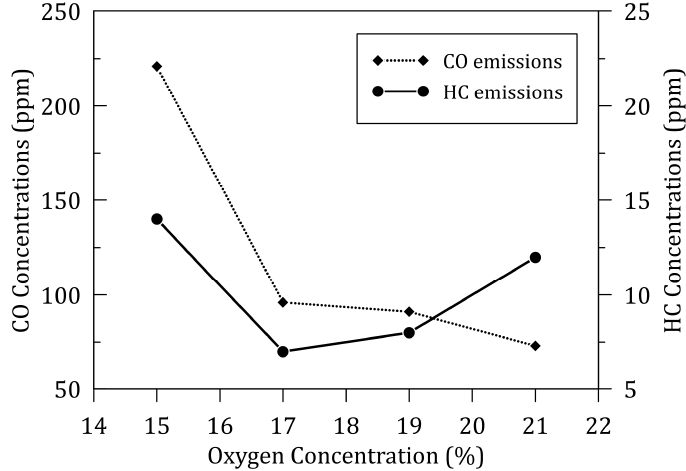
Figure 18. CO and HC emissions concentration in the case of EGR.